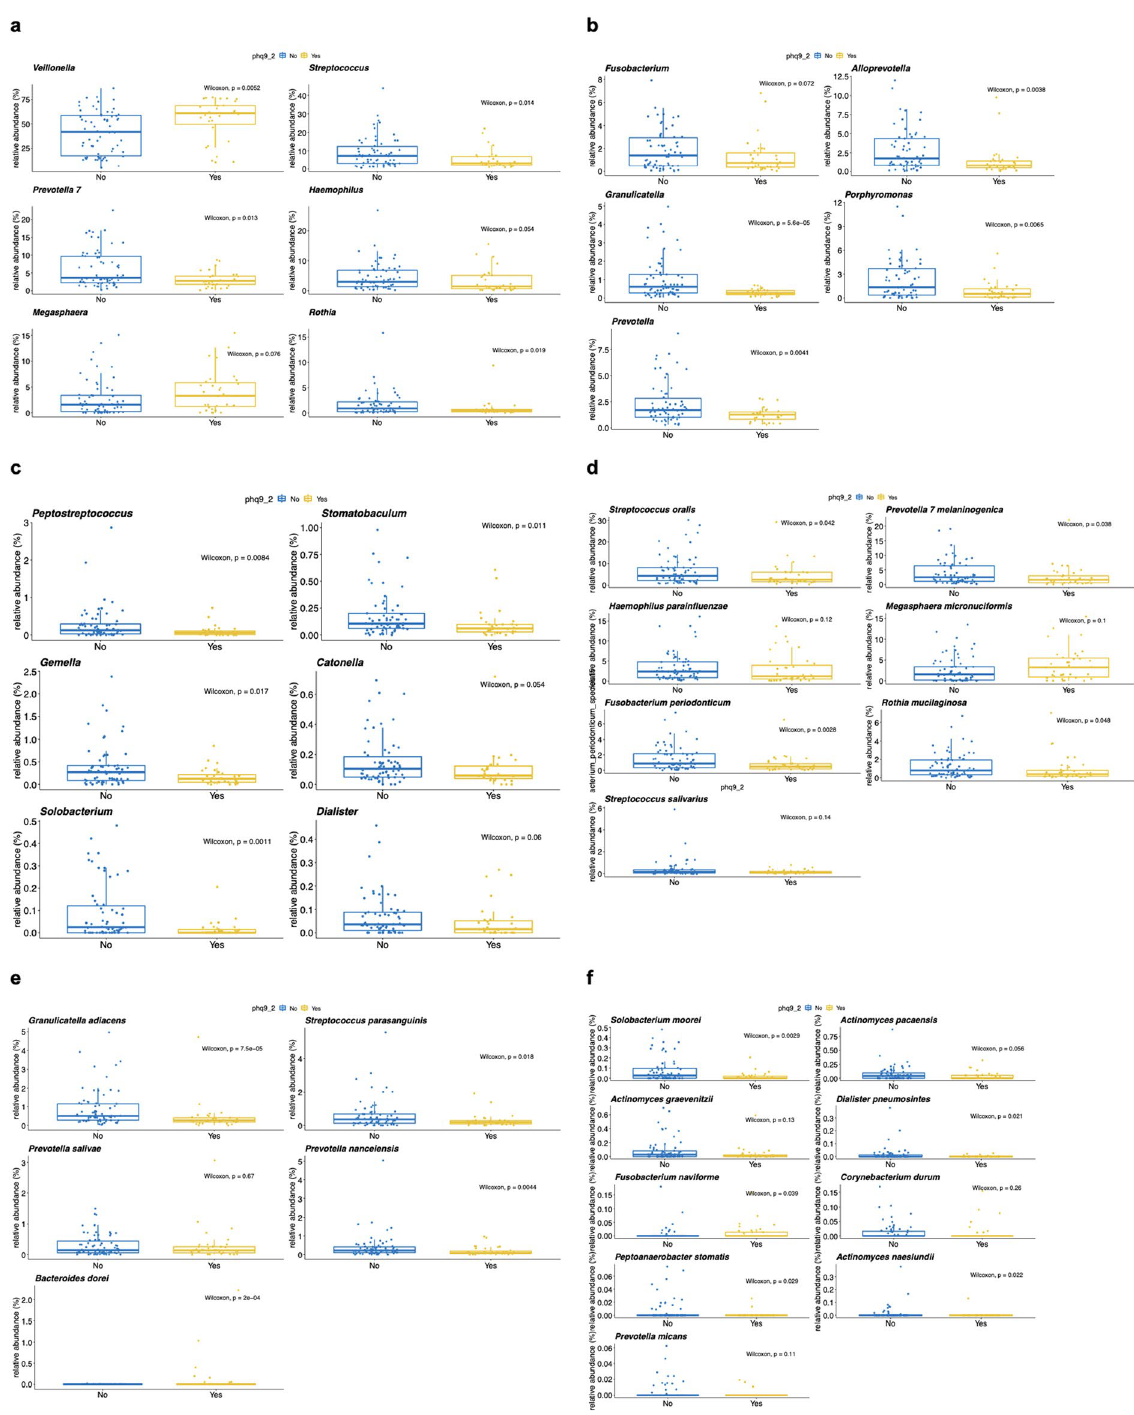
Figure 4. Differentially abundant genera and species in individuals with suicidal ideation (SI) vs individuals without SI (NOSI) after controlling for sex, diet, sleep, and HLA genetics. Wilcoxon statistics (N = 93, SI = 31, NOSI = 62) for relative abundances compared between SI and NOSI according to a 1:2 nearest neighbor selection using propensity score matching paradigm on sex, five dietary habits, presence of sleep issues, and HLA genetics at DRB1*15, DQA1*01, DQB1*03, DPB1*05, and A*30 (haplotypes that were earlier identified to either carry increased risk or appear to be protective for SI in the cohort). Relative abundance (%) is on the y axis. Significant results are presented here at the genus ( a – c ) and species ( d – f ) taxonomic